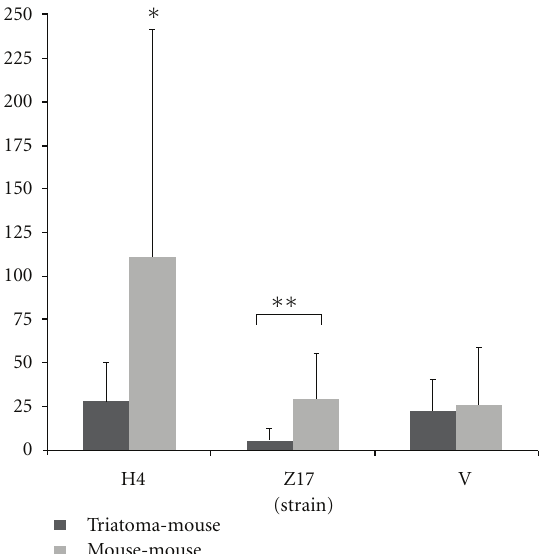
Figure 4: Number of amastigote nests from T. cruzi in 100 fields, 40x of cardiac tissue from infected BALB/c mice with the H4, Z17, and V strains ( ∗ P < 0 . 05 in comparison with all evaluated groups. ∗∗ P < 0 . 05 in comparison between both groups).